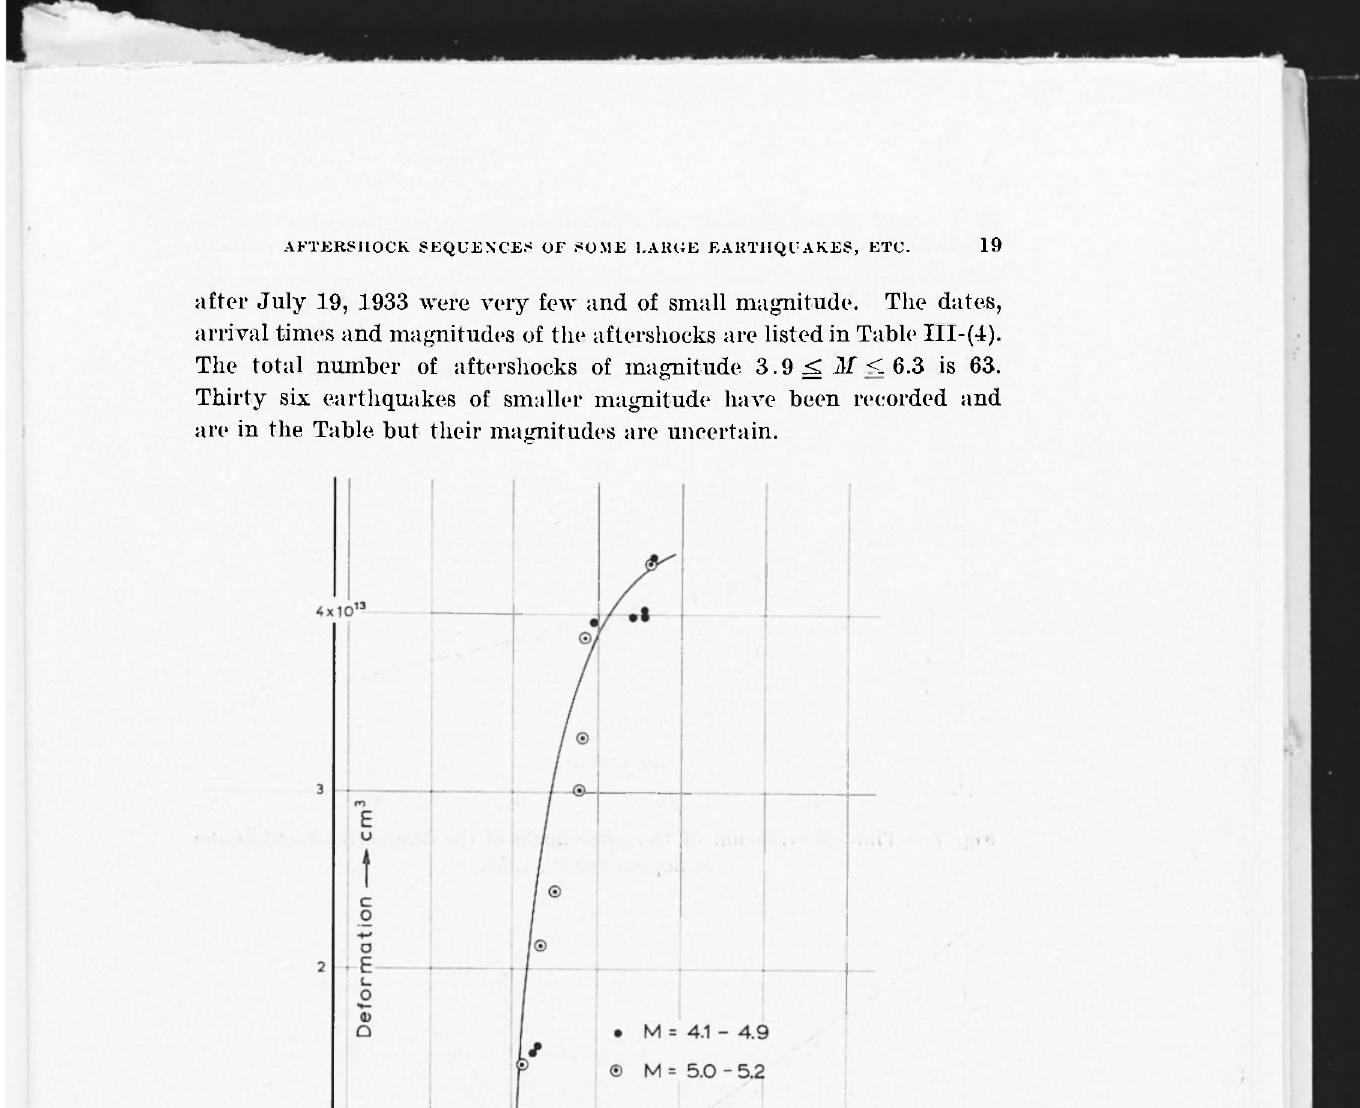
Fig. 6 - Deformation characteristics of the aftershock sequence of the Corinth Earthquake of April 22,